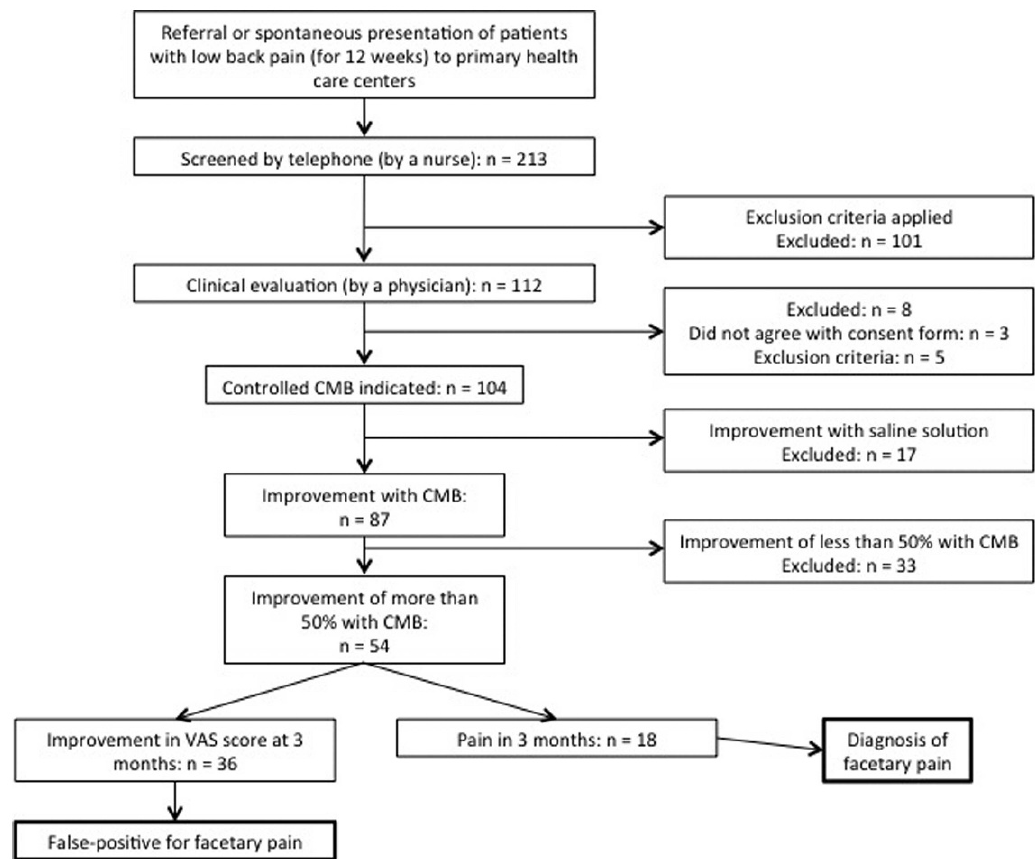
Figure 2 - Flowchart detailing the inclusion and exclusion criteria of patients in the diagnostic